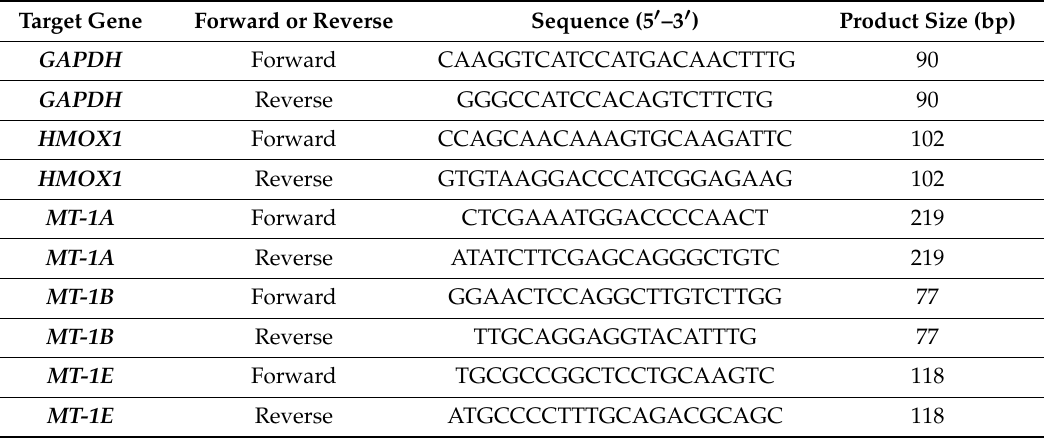
Table 1. Details of primers used for